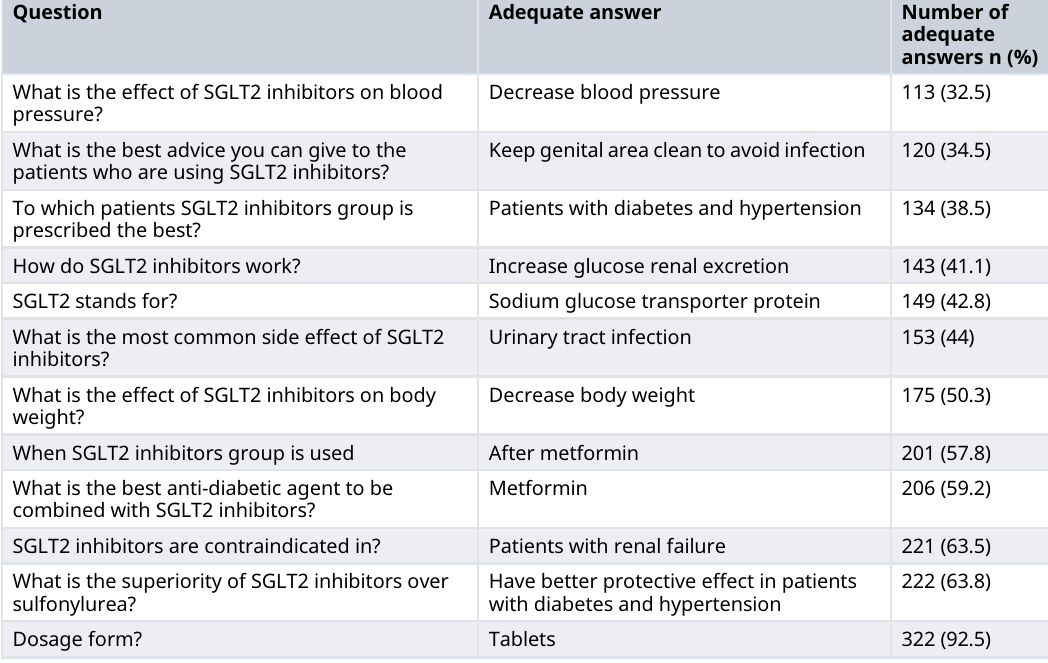
Table 2. Community pharmacists ’ knowledge about SGLT2 inhibitors (data are represented as frequencies).